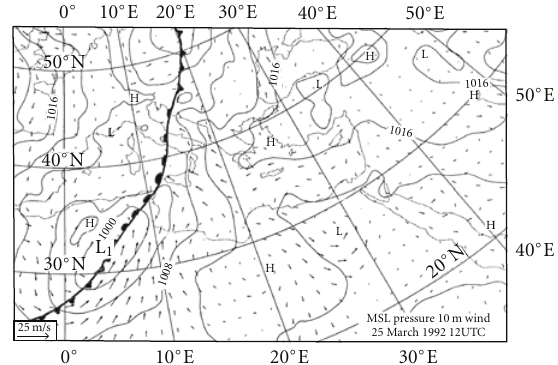
Figure 1: Mean sea level objective pressure analysis at 12:00 UTC on 25 March 1992. Isobars: every 4 hpa. The fronts are denoted by the conventional symbols and are transferred from the Hellenic National Meteorological Center respective subjective analysis. The scale of the wind velocity is at the lower left